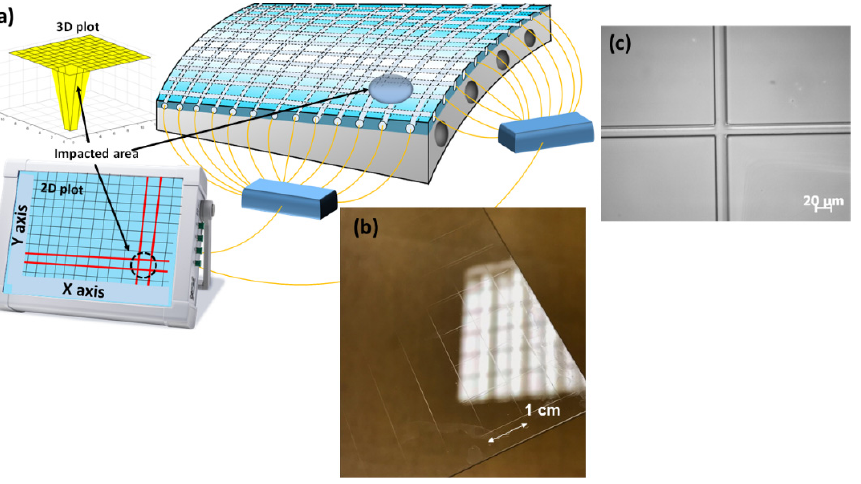
Figure 1. Two-dimensional sol-gel matrix sensor for damage or delamination detection. ( a ) Sensor principle where damage leads to the rupture of one or several TiO 2 –SiO 2 guides. Its localization can be deduced thanks to the 2D structure. ( b ) Example of a 2D grid waveguide obtained on soda-lime substrate glass. ( c ) TiO 2 –SiO 2 grid observed with an optical microscope. This figure is adapted from [10].